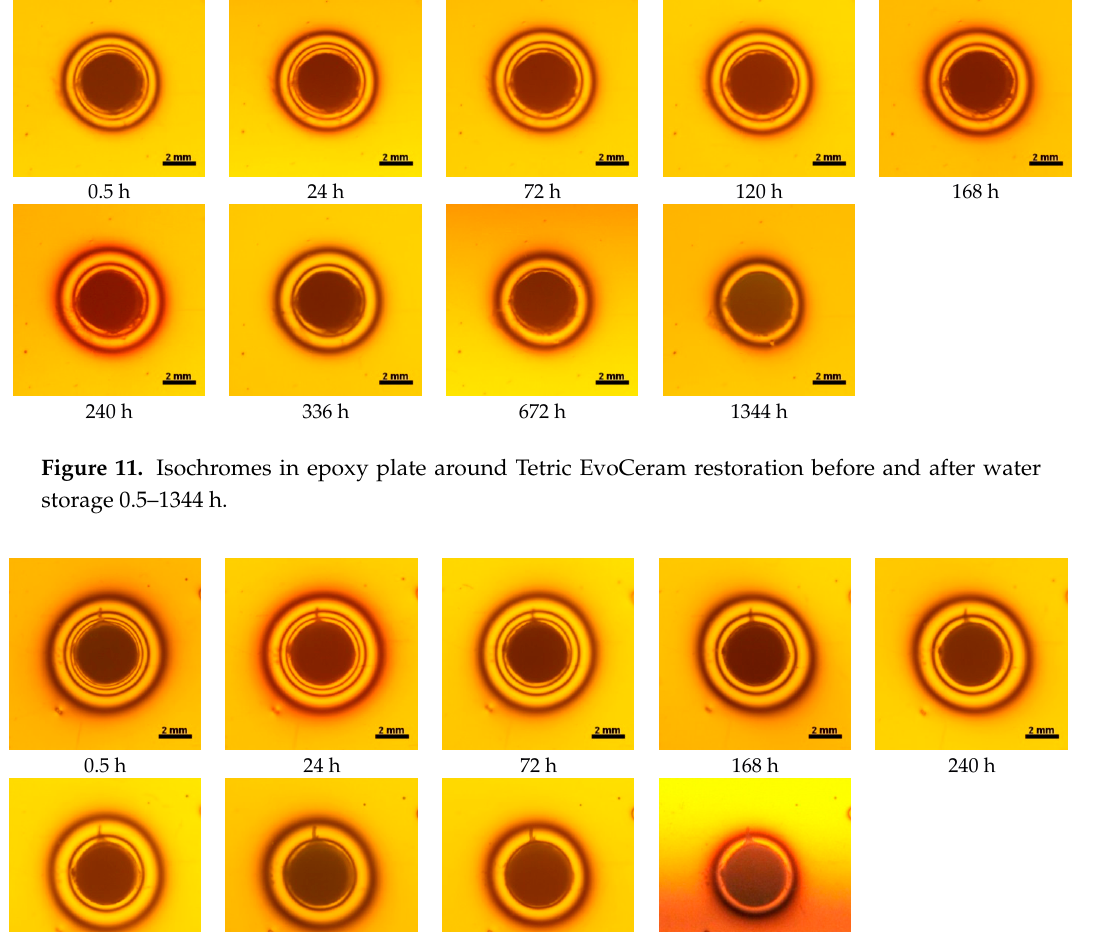
Figure 12. Isochromes in epoxy plate around Heliomolar Flow restoration before and after water storage 0.5–1344 h.